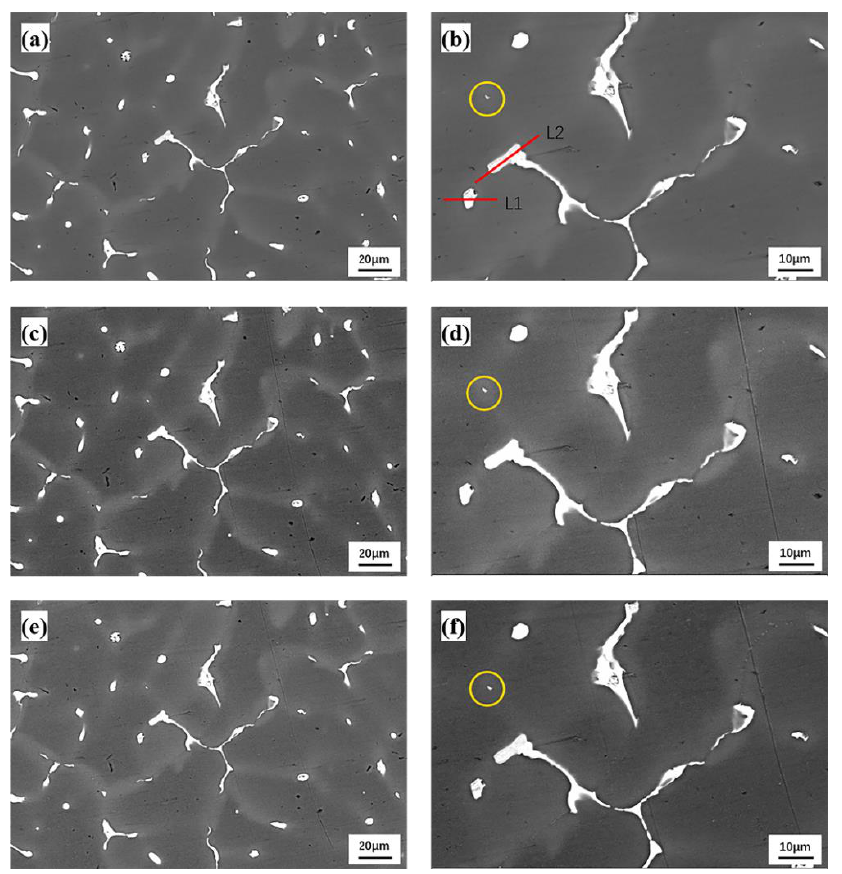
Figure 5. QISOZ backscattered SEM images at 500 times ( a , c , e ) and 1000 times ( b , d , f ) magnification at 100 °C ( a , b ), 200 °C ( c , d ) and 300 °C ( e , f ).